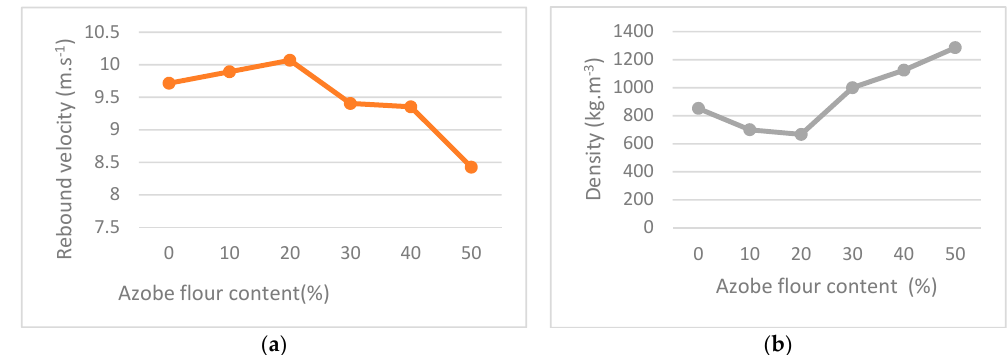
Figure 8. Wood flour content dependence of ( a ) impactor’s rebound velocity ( b ) WPC density.